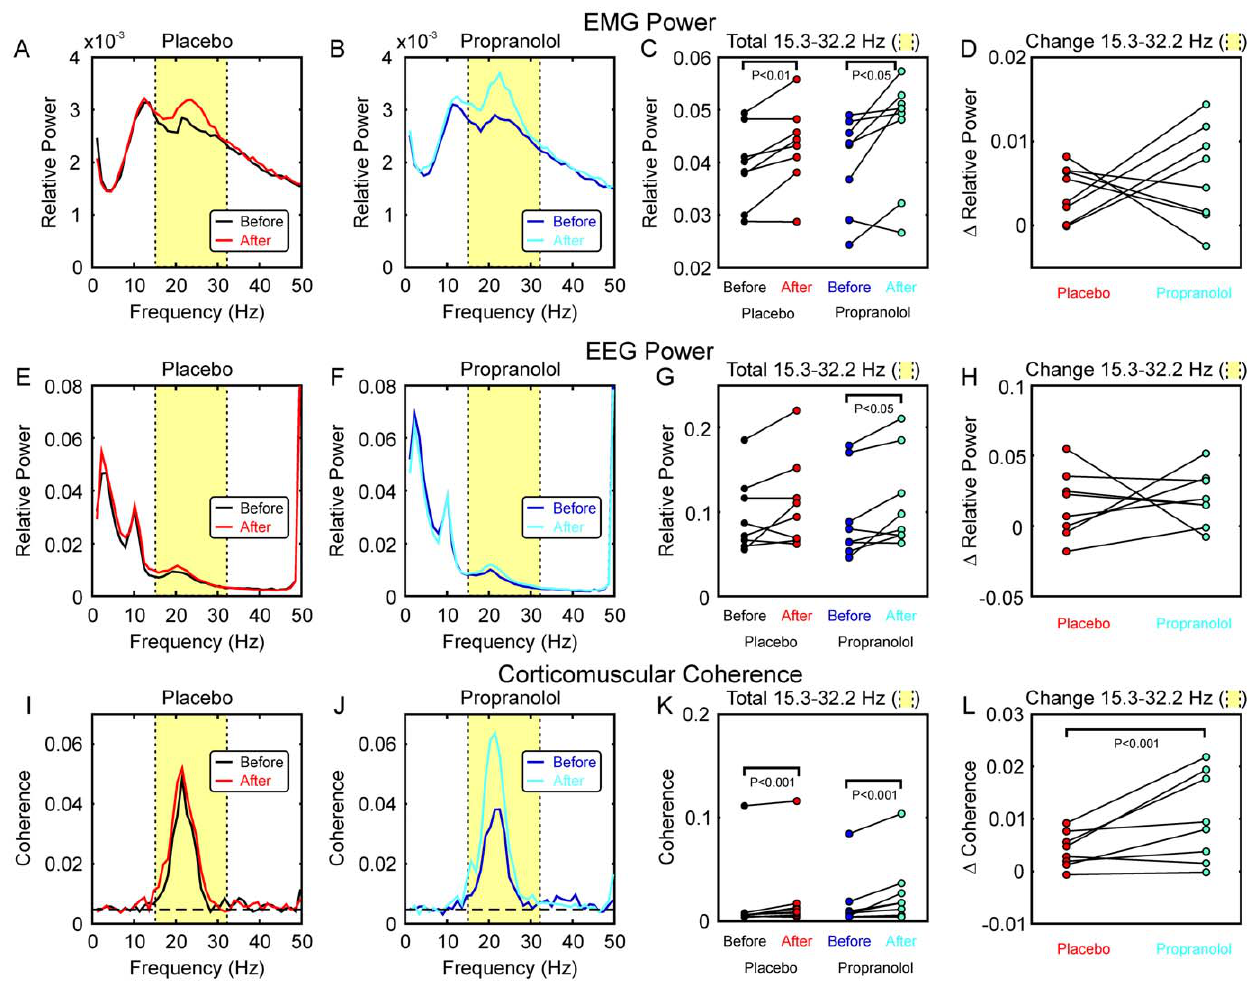
Figure 4. Effects of Propranolol on Beta-band Oscillations during the Auxotonic Precision Grip Task. A,B, EMG power spectra, averaged across all eight subjects and five muscles, before and after administration of placebo (A) and propranolol (B). C, total EMG power in the 15.3–32.2 Hz beta band (shaded yellow in A,B), plotted for single subjects before and after placebo and propranolol. Both substances significantly increased EMG beta power. D, changes in EMG power in the 15.3–32.2 Hz band produced by placebo and propranolol. Each point is the difference of the ‘after’ and ‘before’ points from the corresponding subject in (C). There was no significant difference in the change in beta-band power between placebo and propranolol. E–H, similar display as (A–D), but for EEG power. Propranolol significantly increased EEG power in the beta band, but there was no significant difference between the changes seen after placebo and propranolol. I–L, similar display as (A–D), but for corticomuscular coherence (averaged over all five available muscles). Dashed horizontal lines in (I,J) mark the significance level for the averaged coherence (P , 0.05). Coherence was significantly increased after both placebo and propranolol (K), but the change in coherence was significantly greater for propranolol than for placebo